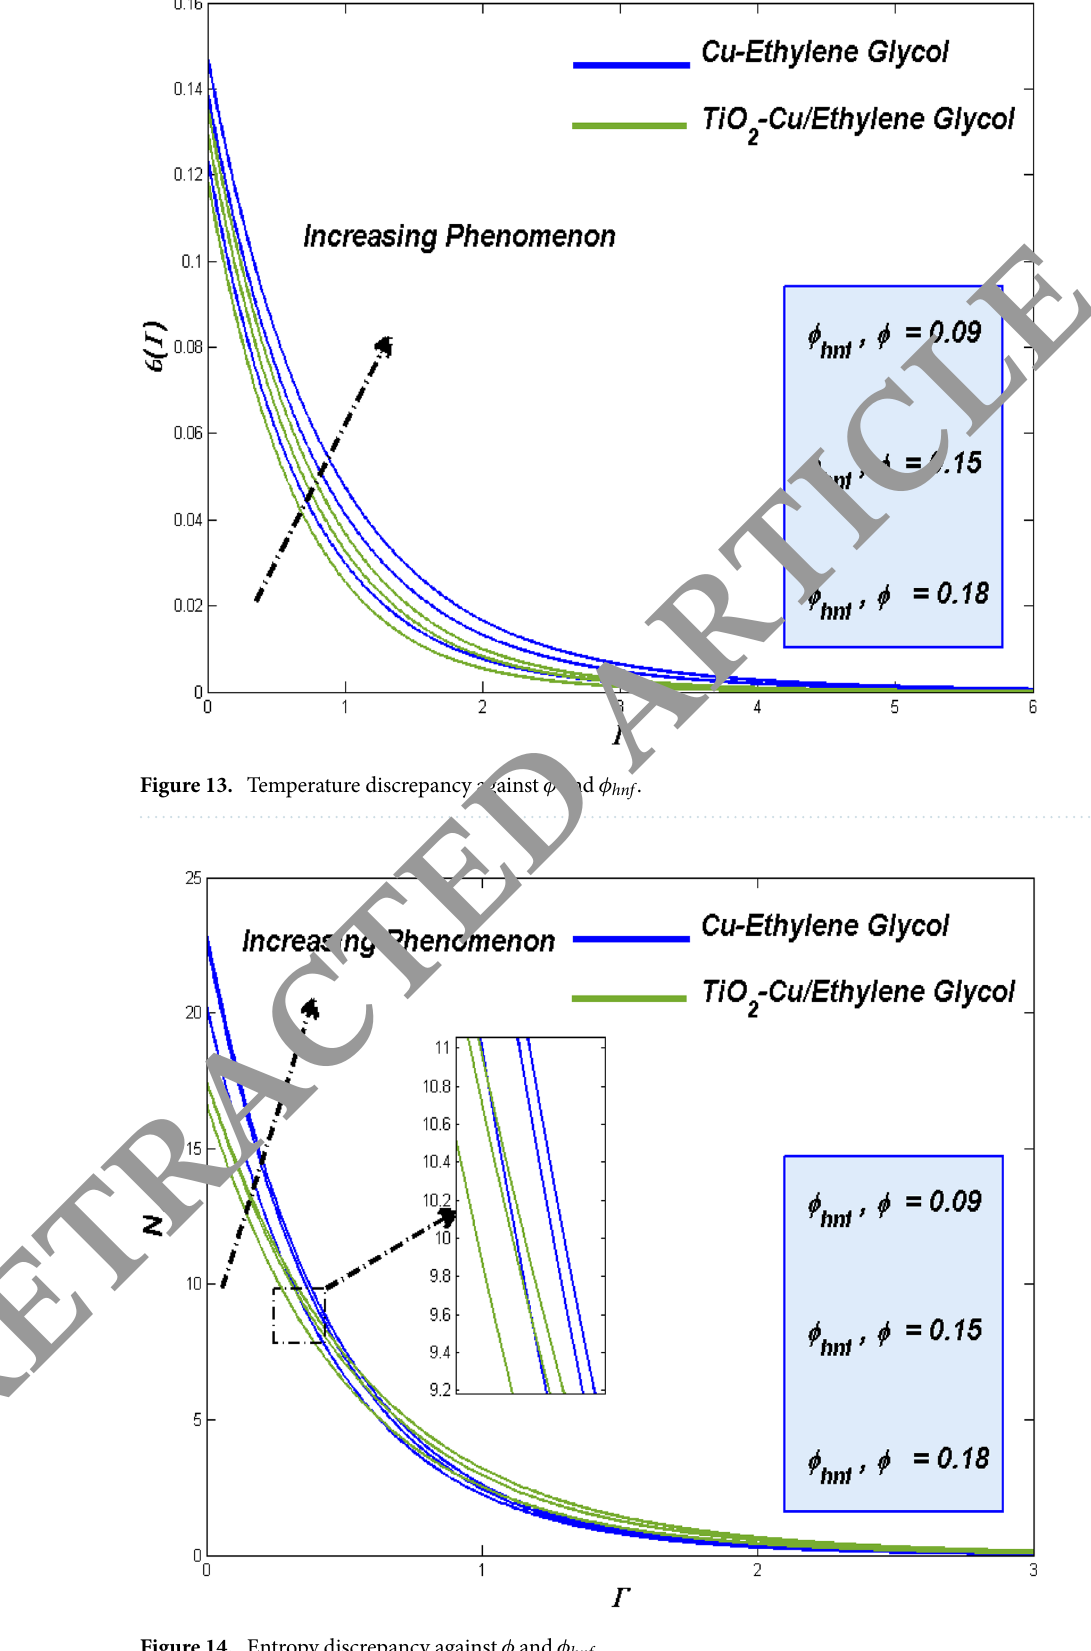
Figure 14. Entropy discrepancy against φ and φ hnf